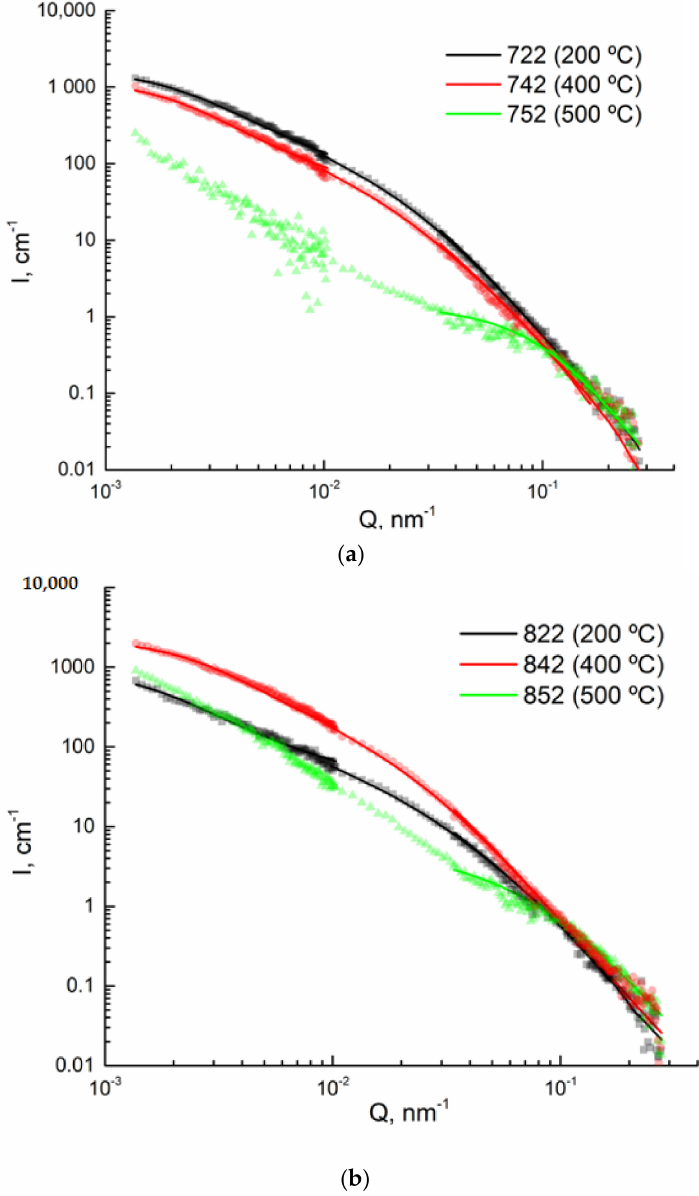
Figure 13. USANS data with fitted model curves: ( a ) 42SiCr, ( b ) 42SiCr +